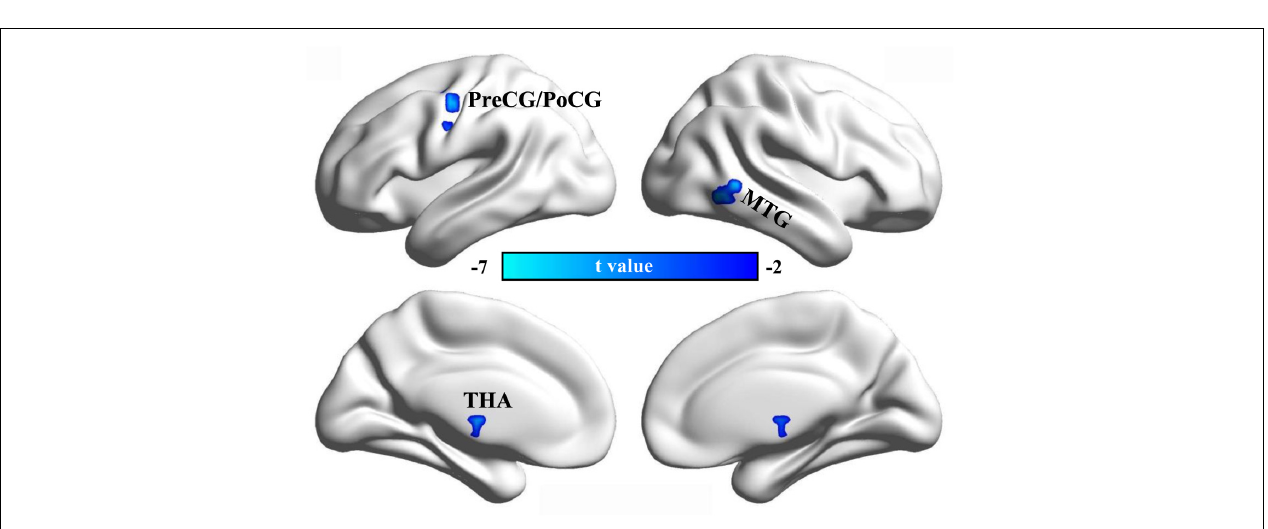
FIGURE 1 | Changed static ALFF in CDP patients. A two-sample t -test was used to compare the static ALFF maps between CDP patients and healthy controls. Significantly increased static ALFF in left anterior insula and left posterior precuneus were found in CDP patients. Moreover, significant reeducations of static ALFF in left precentral/postcentral gyrus, subgenual anterior cingulate cortex, and thalamus were found in CDP patients.